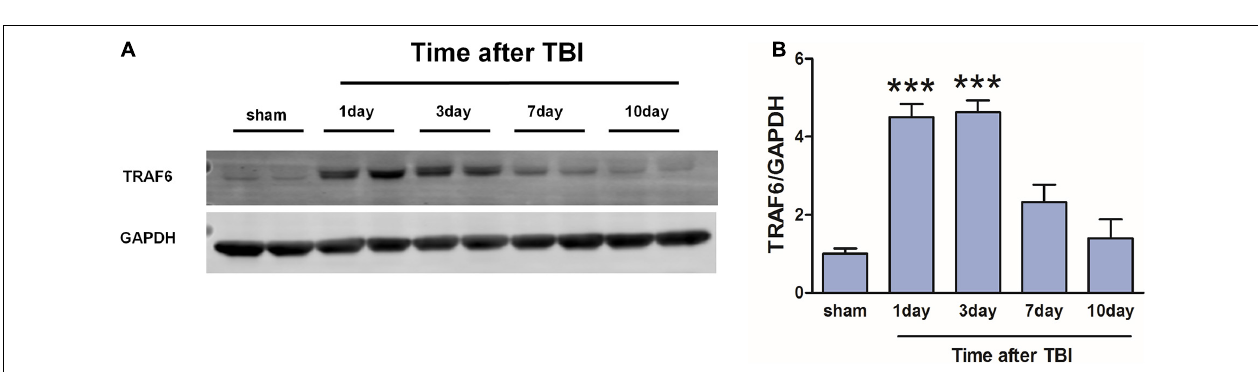
FIGURE 2 | Upregulation of TRAF6 in neurons and astrocytes at the injury site following experimental TBI in rats. TRAF6 (red), GFAP, NeuN and IBA-1 (green), and merged showing the specific cell types expressing TRAF6 (A–I) . TRAF6 was co-localized mainly with the astrocytic marker GFAP (A–C) , less frequently with the neuronal marker NeuN (D–F) , and rarely with the microglial marker IBA-1 (G–I) . (J) Quantification of co-expression showing that TRAF6 was upregulated mainly in cells positive for the astrocytic marker GFAP and the neuronal marker NeuN.